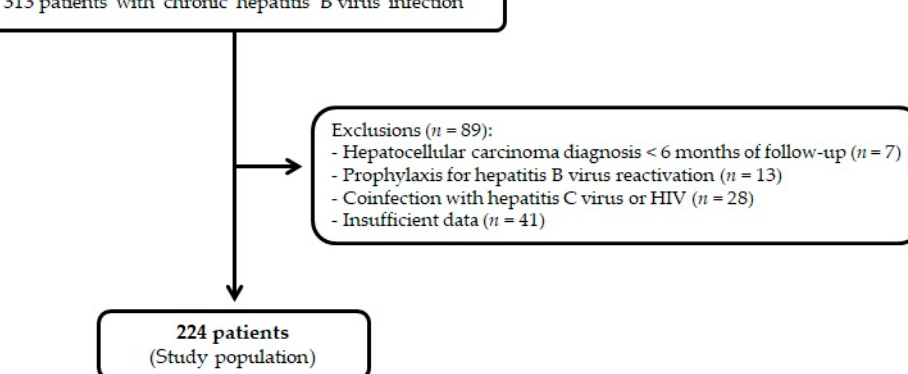
Figure 1. Flowchart of study population enrollment.